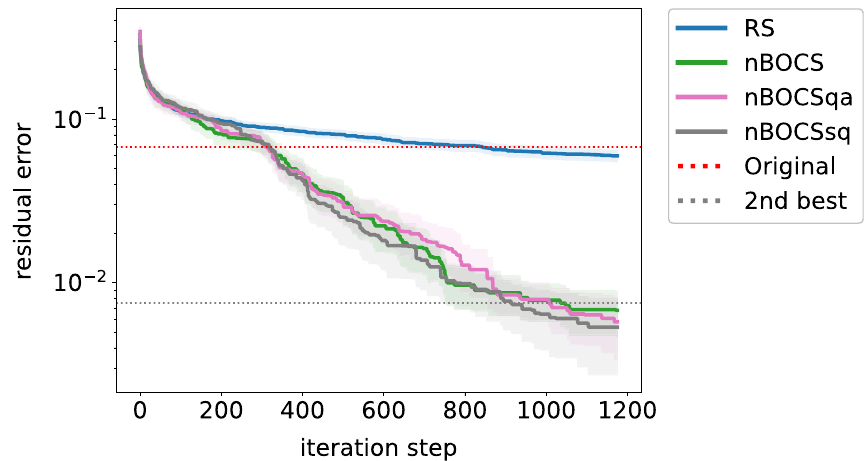
Figure 2. The residual error of lossy compression of a matrix as a function of iteration step among the Ising solvers (SA, QA and SQ).